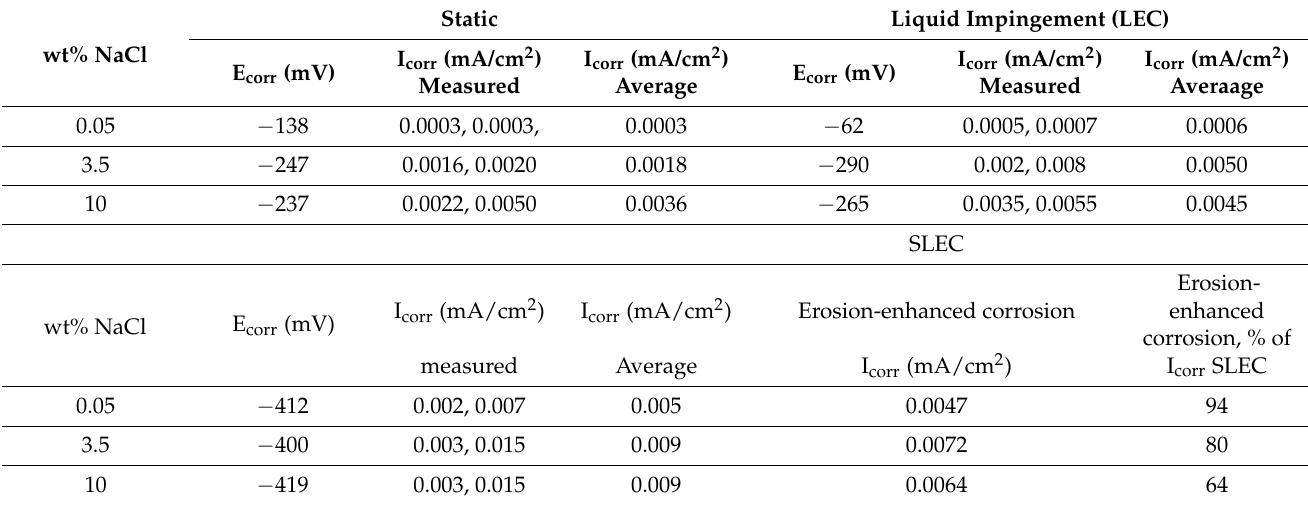
Table 5. Corrosion rates of UNS S32760 in the different hydrodynamic conditions.